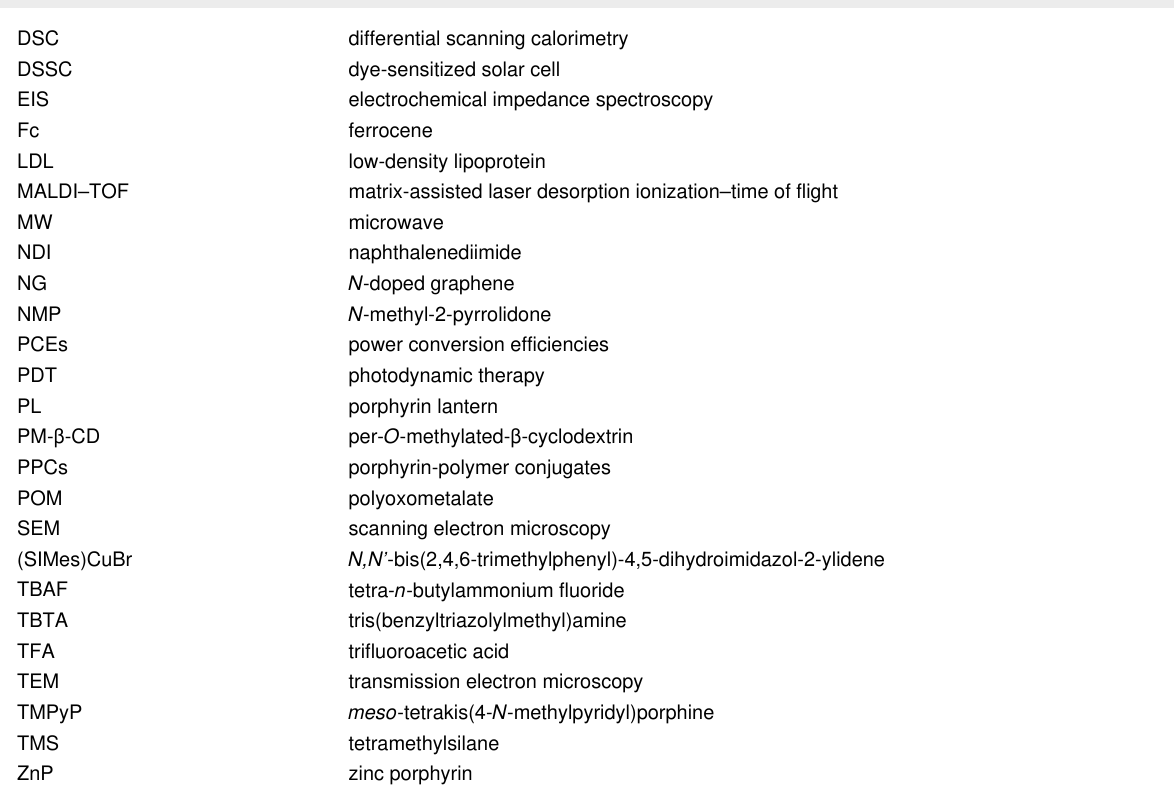
Table 1: Synonyms and abbreviations with their explanations. (continued)